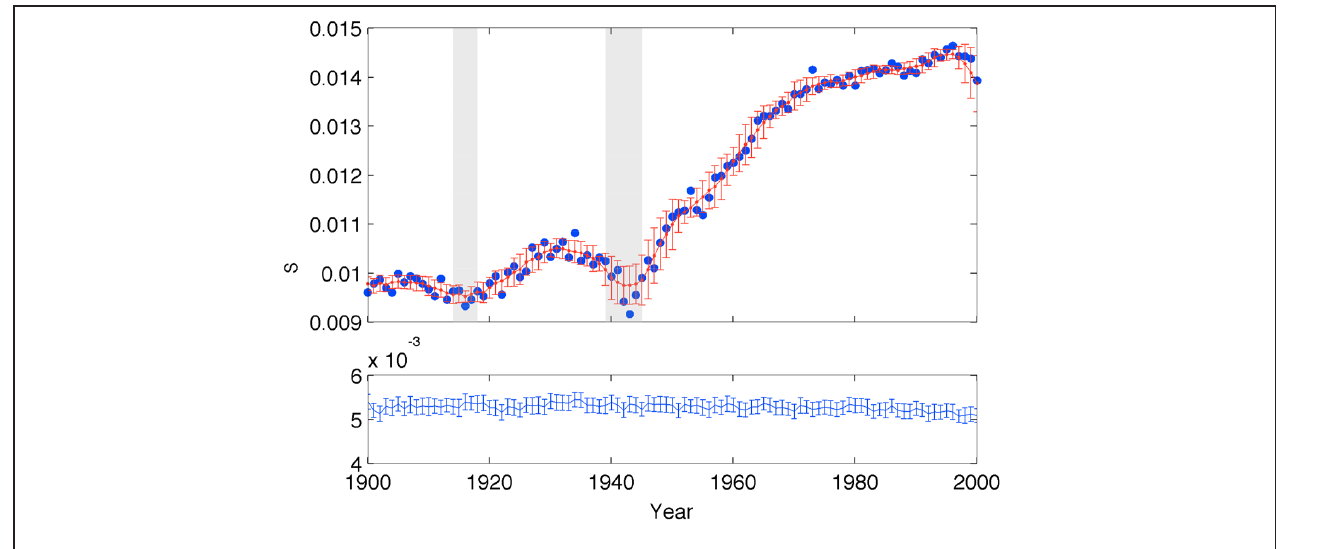
correspond to the two World Wars, and the red vertical dashes the standard deviation of the null hypothesis. Bottom : mean and standard deviation of the null hypothesis corresponding to randomized word